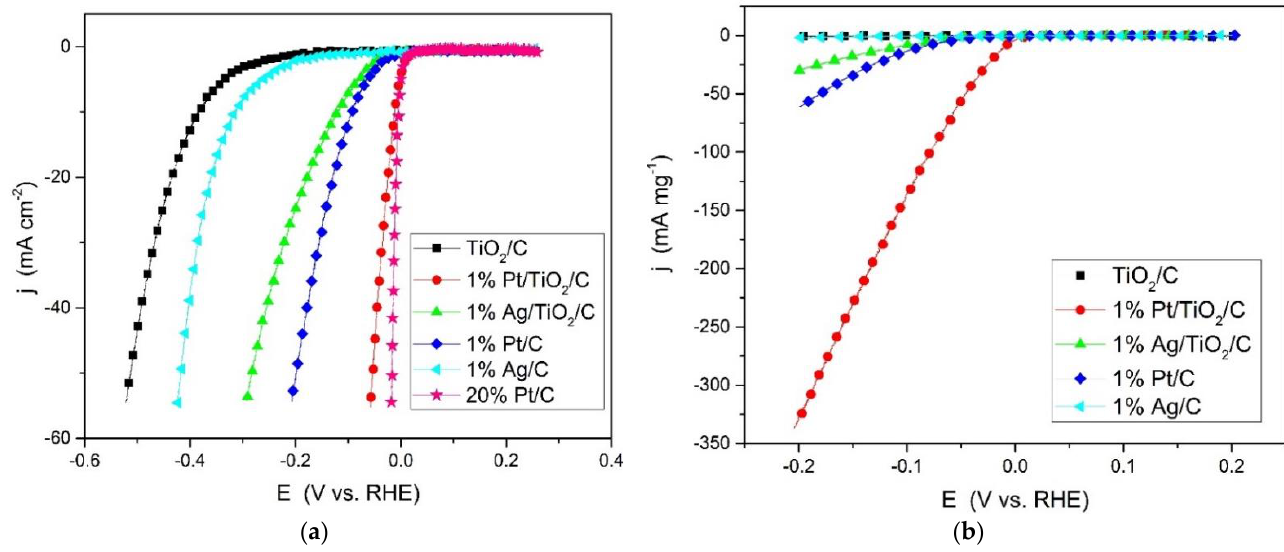
Figure 5. IR-corrected RHE polarization curves measured at the disk electrode in Ar-saturated 0.5 M H 2 SO 4 solution ( a ) and normalized by catalyst mass ( b ). Scan rate: 5 mV s −1 . Rotation rate: 3600